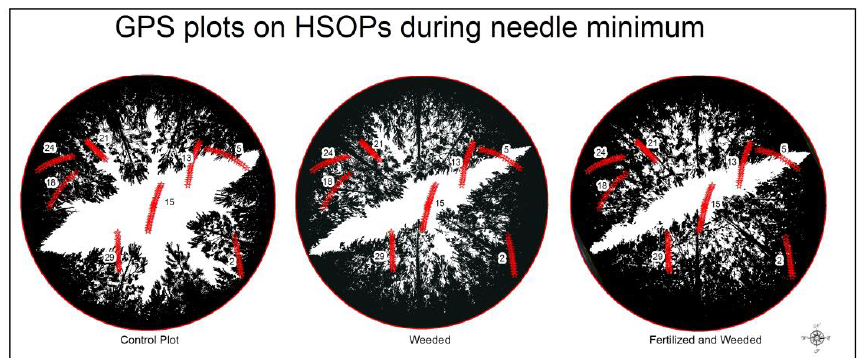
Figure 4. The resulting binary Hemispherical Sky-Oriented Photos (HSOPs) taken at the Intensive Management Practice Assessment Center managed forest taken during the needle minimum period with the GPS satellite vehicle positions (red circles) plotted inside the image.